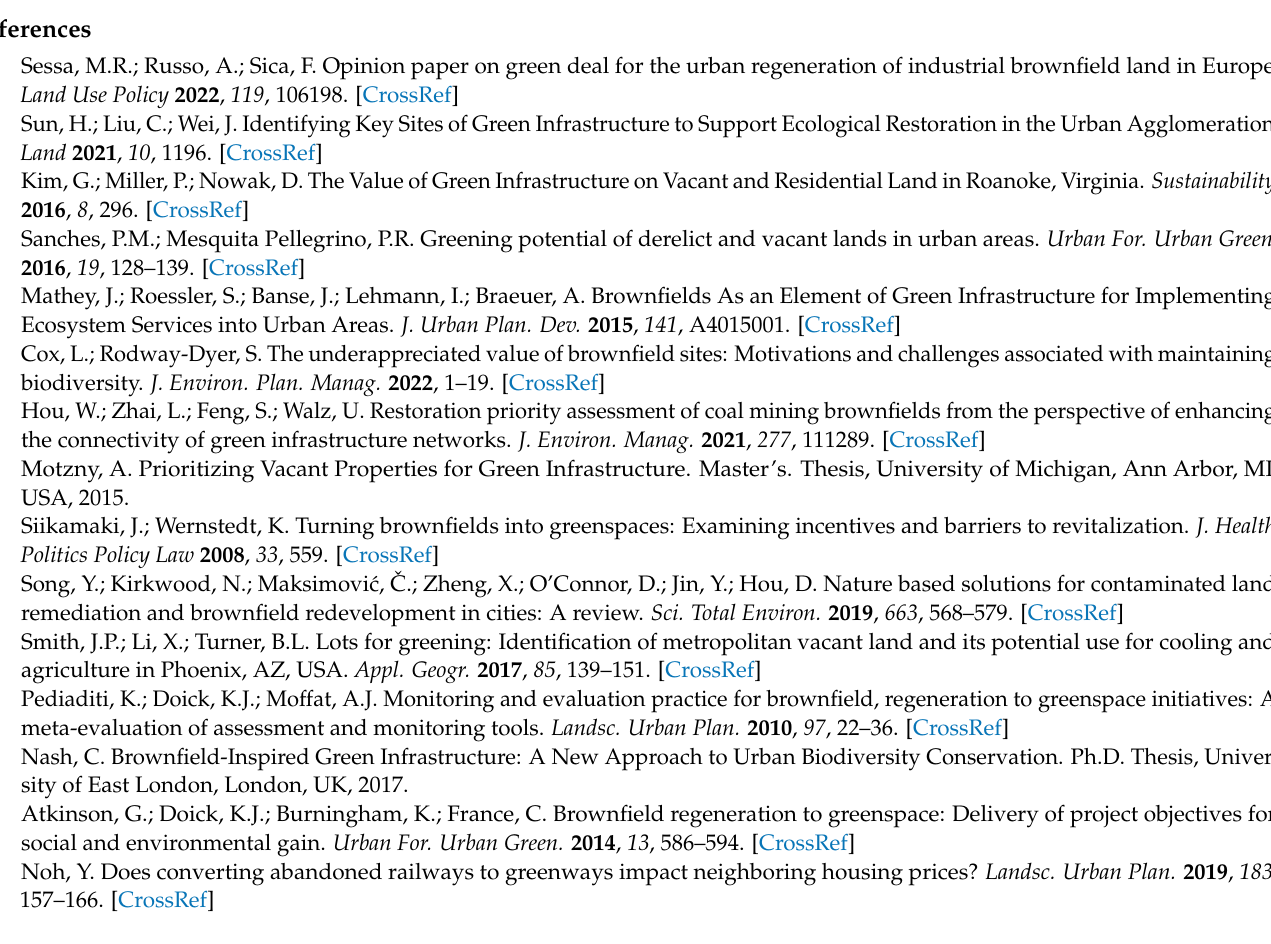
Figure A7. Single value of site suitability based on “Burial of underground cultural relics”.